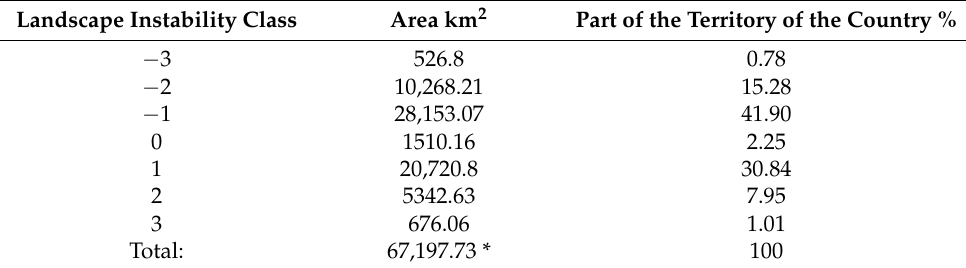
Table 5. Landscape instability in Lithuania,